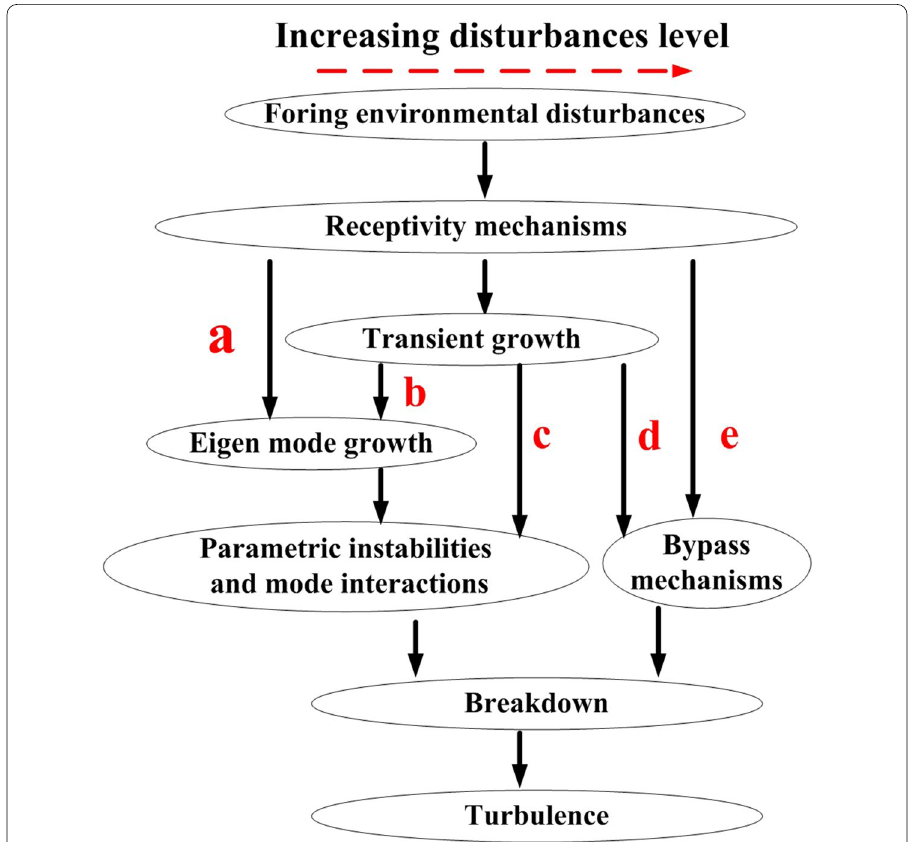
Fig. 1 Boundary layer transition process and path